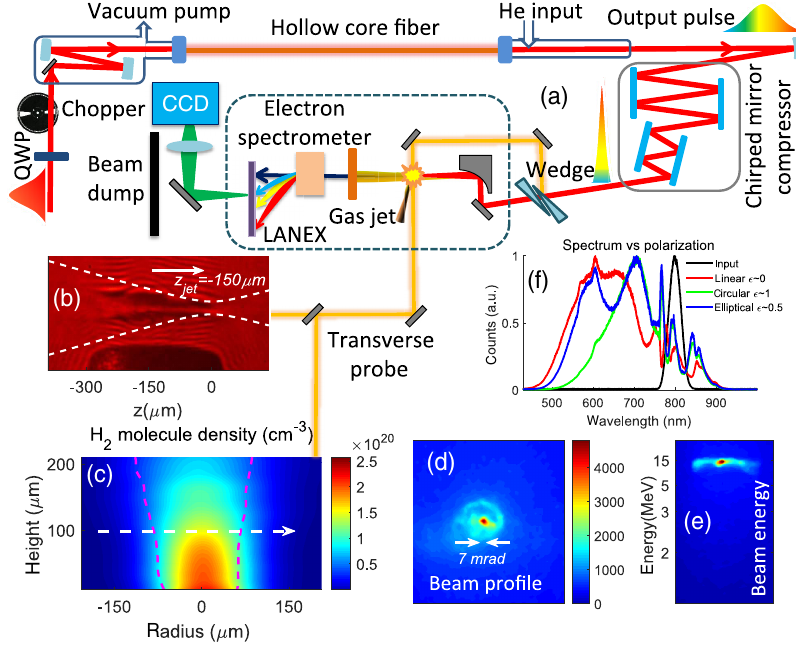
FIG. 1. Experimental setup. (a) Laser pulses with few-cycle duration, generated through a hollow core fiber (HCF) and a chirped mirror compressor, are used to drive electron acceleration from a near-critical-density hydrogen jet target. A probe pulse split from the main drive pulse is used for (b) probing of the few-cycle pulse interaction with the jet and (c) interferometric measurement of the jet density. The white arrows show the drive beam propagation direction, the white dashed lines [(b)] indicate the laser beam 4 e − 2 Gaussian intensity envelope, and the red dashed lines [(c)] show the density FWHM contour. (d),(e) Sample electron beam profile and energy spectrum as imaged on the LANEX screen. (f) HCF output spectrum as a function of input polarization (input energy 6 mJ). Elliptical input polarization ( ε ¼ 0 . 5 ) generates the broadest output spectrum, which is near-circularly polarized. LP beams are polarized left-right in electron beam profile and spectrum images such as (d) and